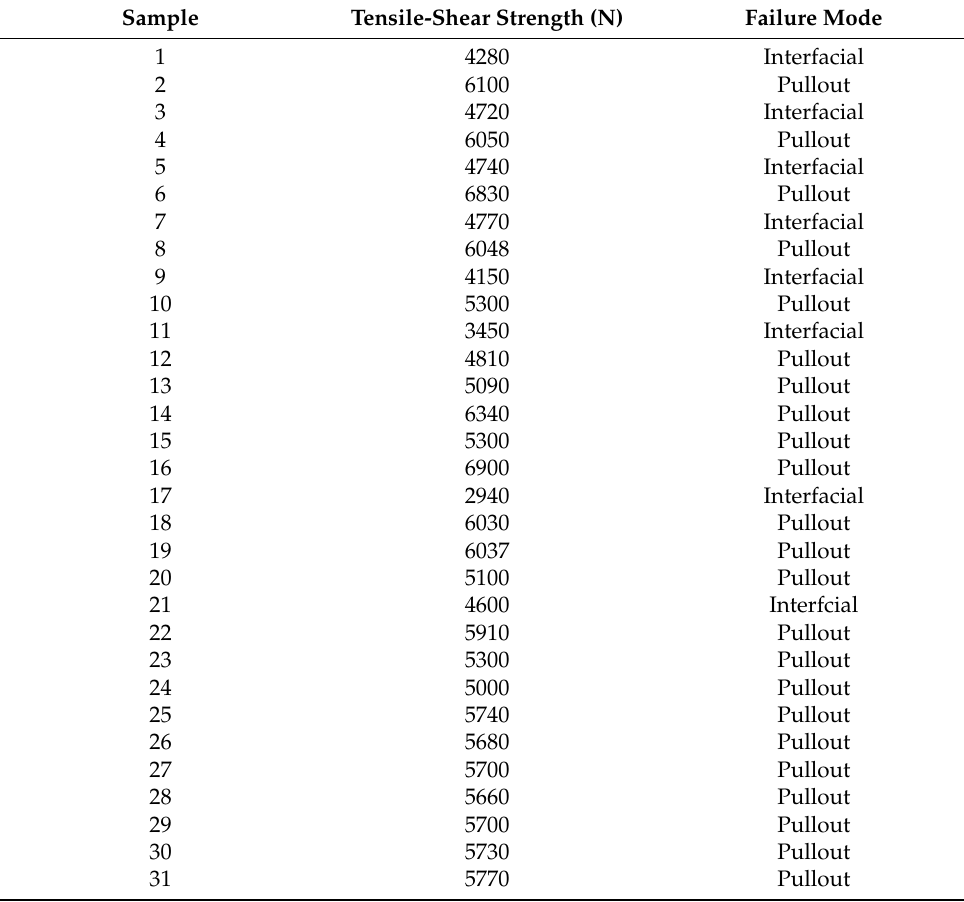
Table 4. The values of TSS and failure modes for the RSW